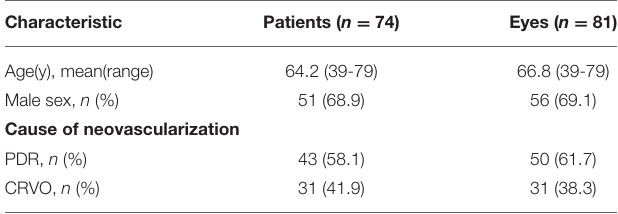
TABLE 1 | Demographic data for 81 eyes in this study.